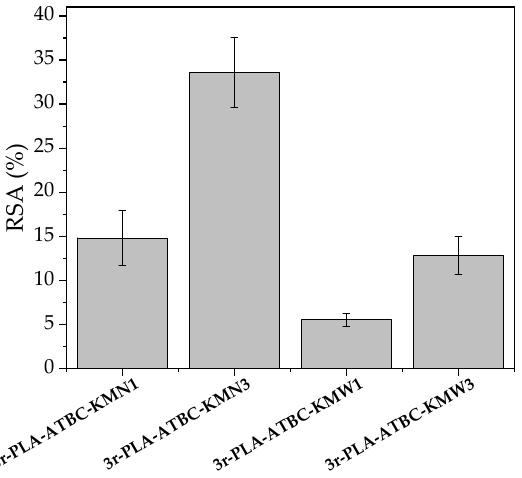
Figure 7. Radical scavenging activity of 3r-PLA-ATBC-based films. As expected, the r3-PLA film did not show any antioxidant activity. The KMN and KMW were processed into thin films and also subjected to the food simulant for